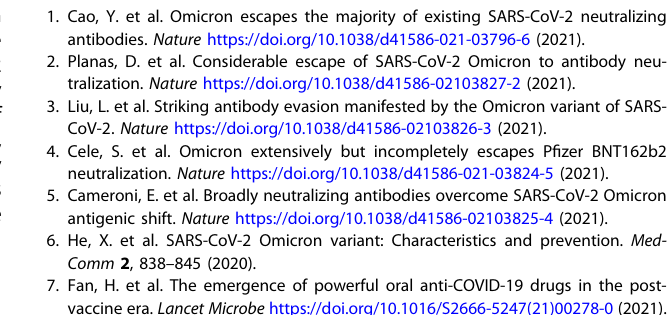
Fig. 1 A schematic illustration of the variant Omicron escaping approved antibodies and vaccines. a FDA has approved several S protein- targeted monoclonal antibodies, in which Bamlanivimab, Etesevimab, Casirivimab, Imdevimab and CT-P59 (Regdanvimab) as well as the serum of all kinds of 2nd vaccine dose, fail to neutralize Omicron variant, while Sotrovimab and convalescent plus vaccinated plasma maintain the ef fi cacy of Omicron variant. b Amino acid substitutions of Omicron variant in the spike protein, some of these mutations in RBD may affect the neutralization activity of group A – F antibodies, respectively. c The neutralizations of seven approved antibodies (Tixagevimab, Cilgavimab, Sotrovimab, Bamlanivimab, Etesevimab, Casirivimab, and Imdevimab) and six vaccines (BNT162b2, mRNA-1273, AZD1222, Sputnik V, BBIBP- CorV, Ad26.COV2.S) against Omicron are displayed, among which Bamlanivimab, Etesevimab, Casirivimab, and Imdevimab completely lose the neutralization while Sotrovimab still can neutralize Omicron variant effectively. All the 1st and 2nd dose vaccine serum fail to neutralize Omicron variant, and both the serum from convalescent patient with vaccination and booster dose of BNT162b2 retain neutralization activity against Omicron